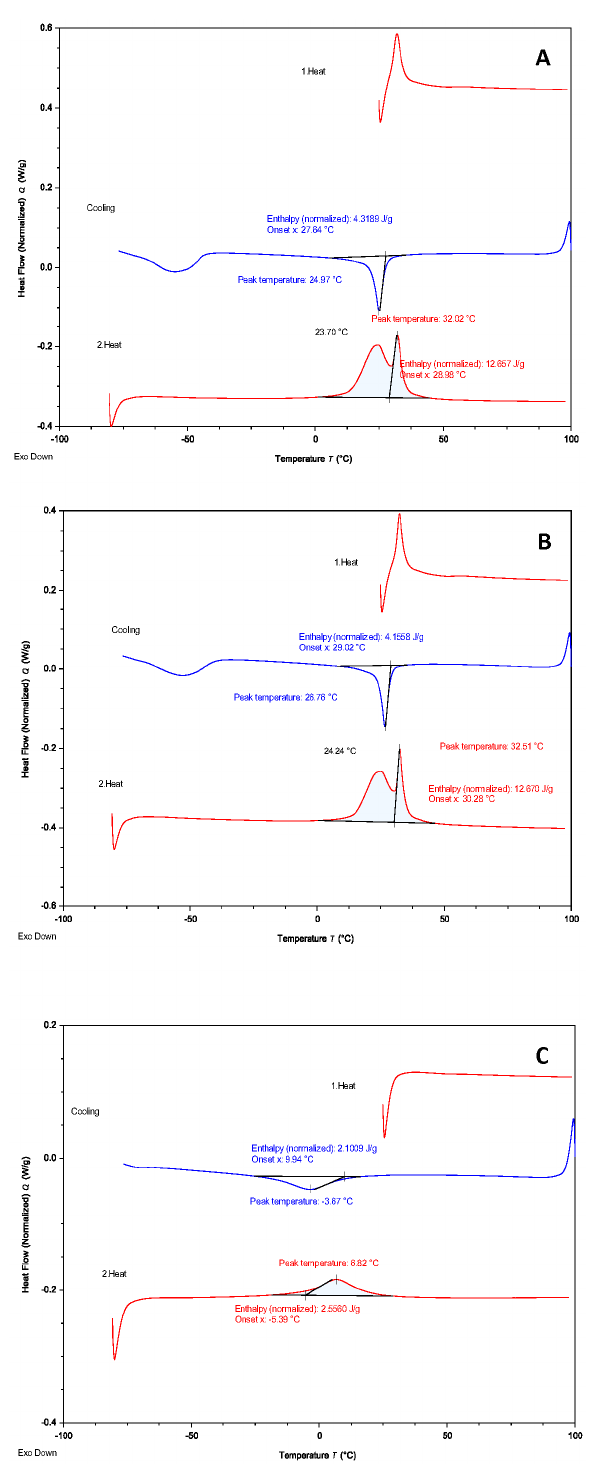
Figure 5. Differential scanning calorimetry (DSC) heating (red lines) and cooling (blue lines) curves of the RACE EVO ( A ), R-Motion ( B ) and RaCe ( C ) instruments. The austenite start temperatures of RACE EVO, R-Motion and RaCe were 23.7 ◦ C, 24.24 ◦ C, and − 5.39 ◦ C, respectively. The austenite finish temperatures (Af temperatures) of tested instruments were determined by locating the intersection of the tangent of the steepest endothermic slope at the austenitic end with the baseline extension of the heating curve [7]. The Af temperatures of RACE EVO, R-Motion and RaCe were 32.02, 32.52